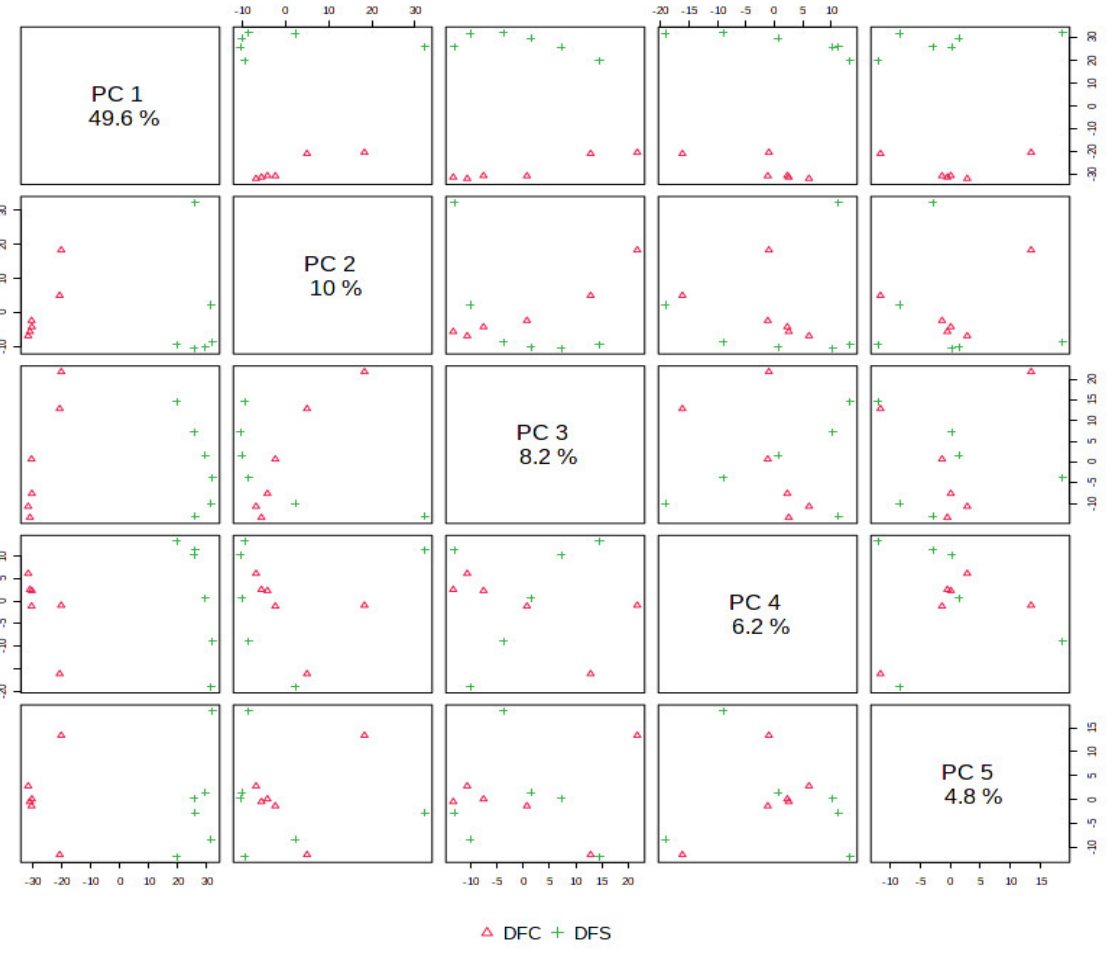
Figure 2. PCA pairwise score plot in unsupervised analysis of DFC and DFS. Different PCs illustrate variability in the spatial distribution of the sample groups.